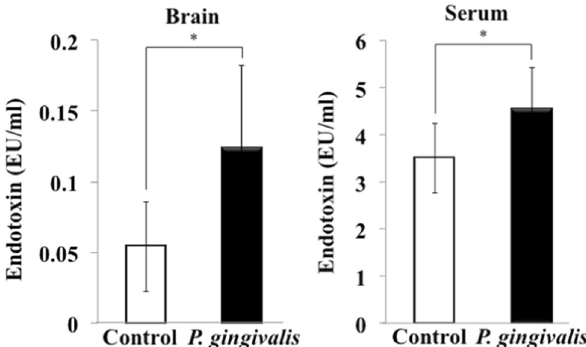
Fig. 4 Concentrations of endotoxin in the brain and serum from P. gingivalis -infected mice. Levels of endotoxin in the brain and serum were measured by Limulus assay. Results are expressed as means ± S.D., * p < 0.05, ** p < 0.01